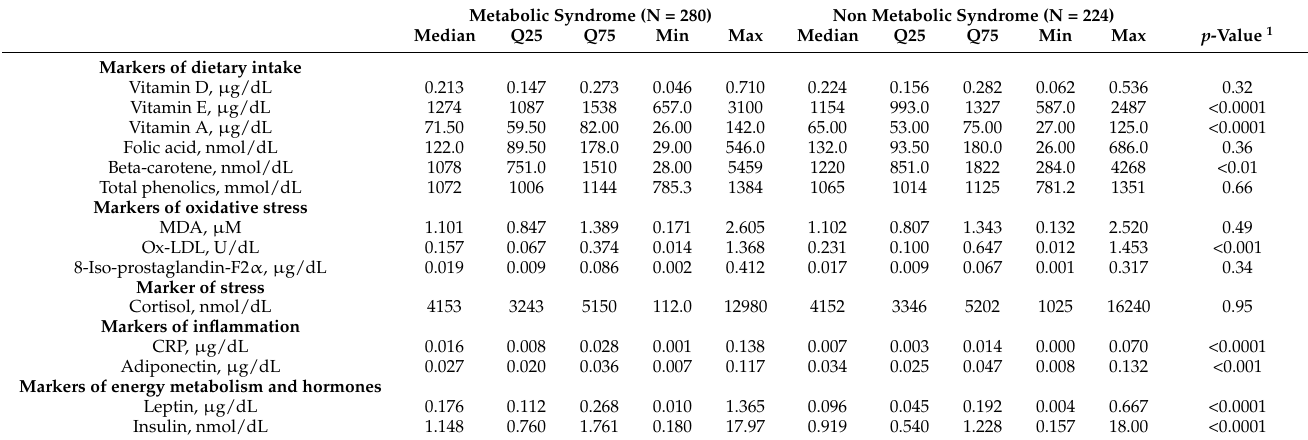
Table 2. Concentration of micronutrients and circulating markers of inflammation and oxidative stress by metabolic syndrome (N =